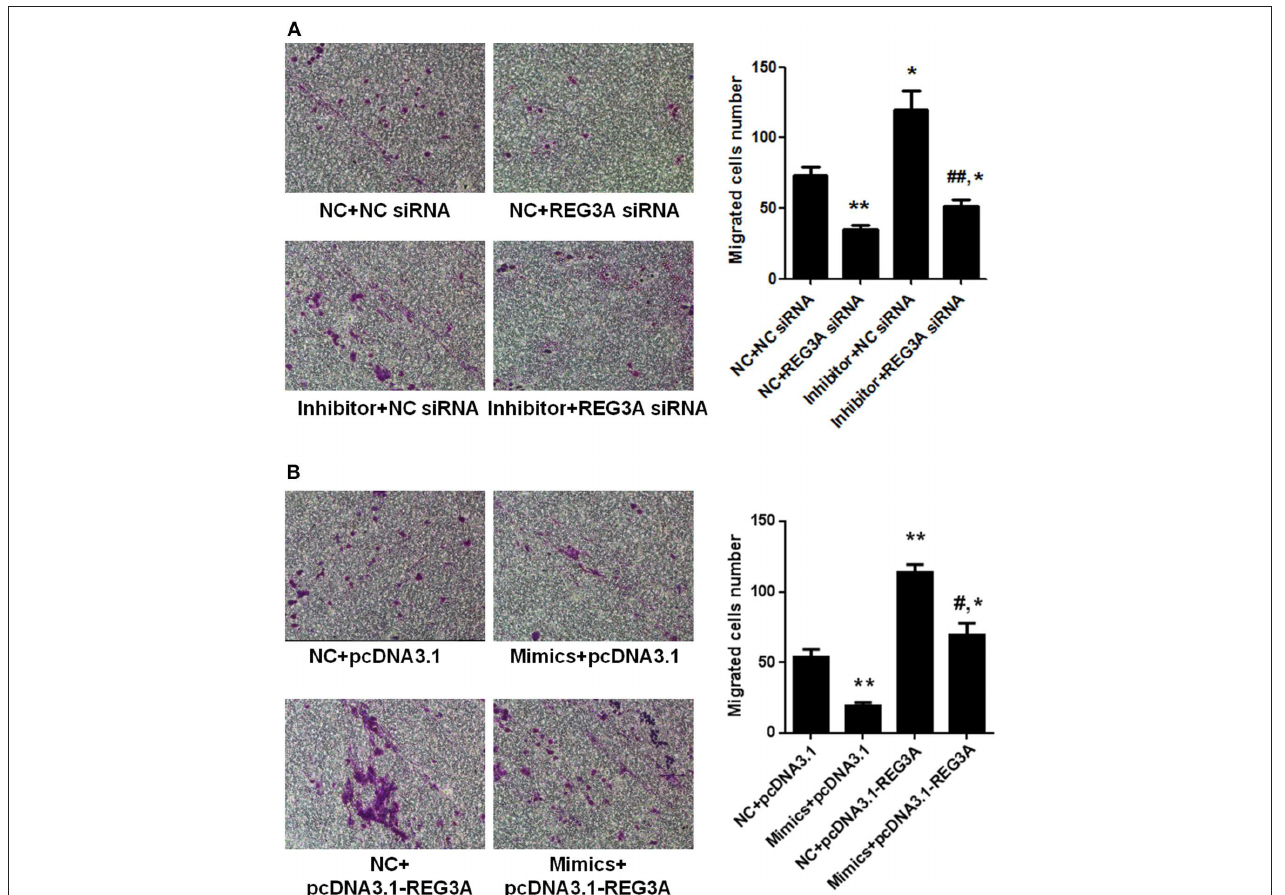
FIGURE 6 | miR-146a inhibited macrophage migration through suppression of regenerating islet-derived protein 3-alpha (REG3A) expression. (A) Monocyte-derived macrophages from the PBMCs of the healthy donors ( n = 3) were transfected with the NC siRNA or REG3A siRNA in the absence or presence of miR-146a inhibitor for 24h. (B) Monocyte-derived macrophages were transfected with the pcDNA3.1-NC or pcDNA3.1-REG3A plasmids in the absence or presence of miR-146a mimics for 24h. All treated cells (2 × 10 5 ) were suspended and added to the upper chamber of transwell well. The medium containing 10% human serum was used as a chemoattractant in the lower chamber. After incubation for 24h, the invaded cells into the lower chamber were stained with crystal violet. The migrated cells were counted, and photomicrographs were taken under an Olympus inverted microscope (IX71, Olympus, Japan). Data are shown as means ± SEM of three independent experiment. * p < 0.05, ** p < 0.01 in comparison with NC + NC siRNA or NC + pcDNA3.1 group. # p < 0.05, ## p < 0.01 in comparison with inhibitor + NC siRNA or NC + pcDNA3.1-REG3A